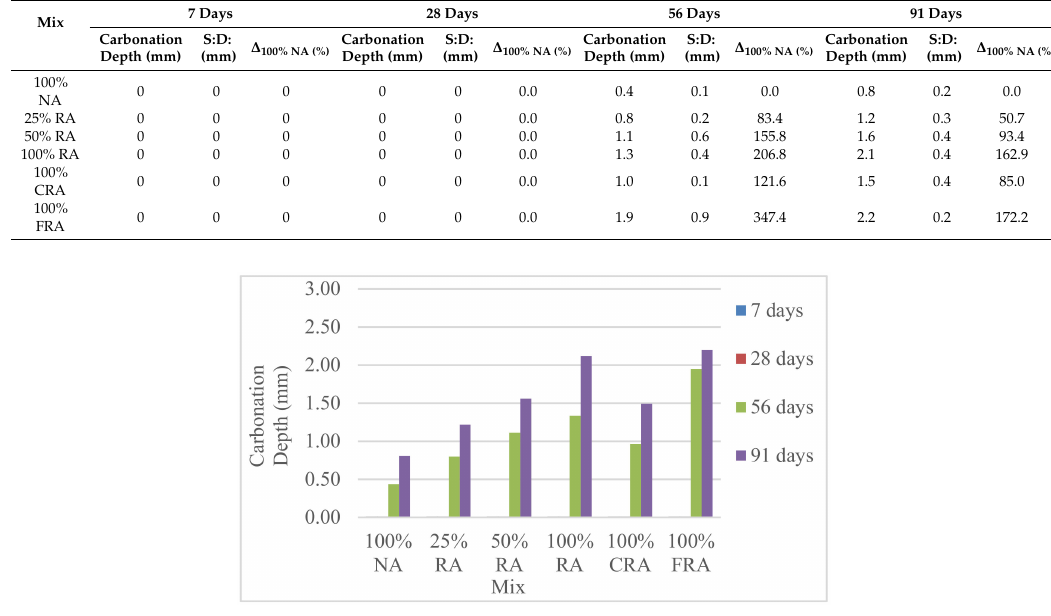
Table 10. Carbonation test results at 7, 56, 28 and 91 days.